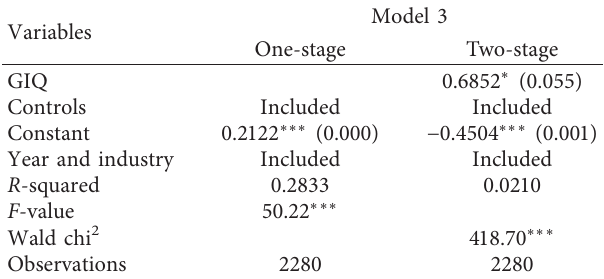
Table 8: Robustness test: panel instrumental variable regression.